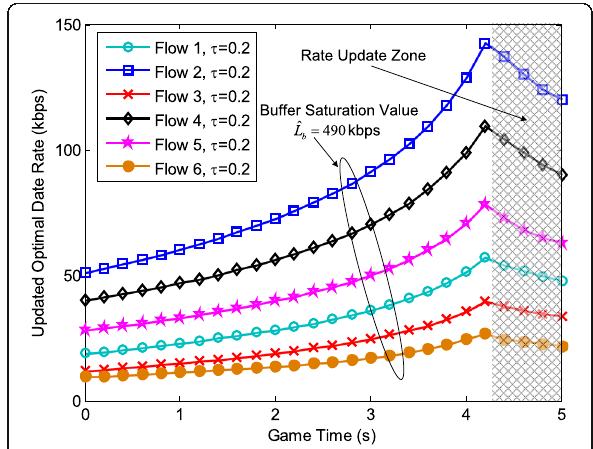
Fig. 11 Optimal data rate comparison among six per-link flows through our proposed ODRU algorithm under saturation value ^ L b ¼ 490 kbps